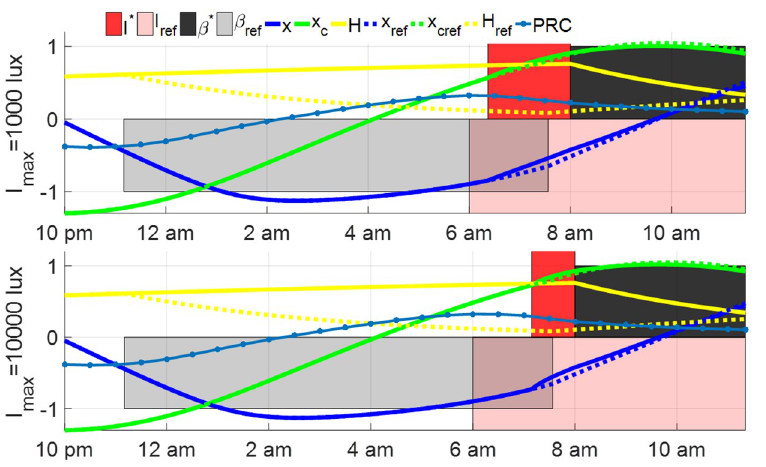
Fig 19. Minimum-time entrainment with optimal light input during the night shift from 10 pm to 8 am with I max = 1000 lux (upper) and I max = 10000 lux (lower). The entrainment time of these two cases is both 3.46 hours (10 hours night shift is excluded from the entrainment